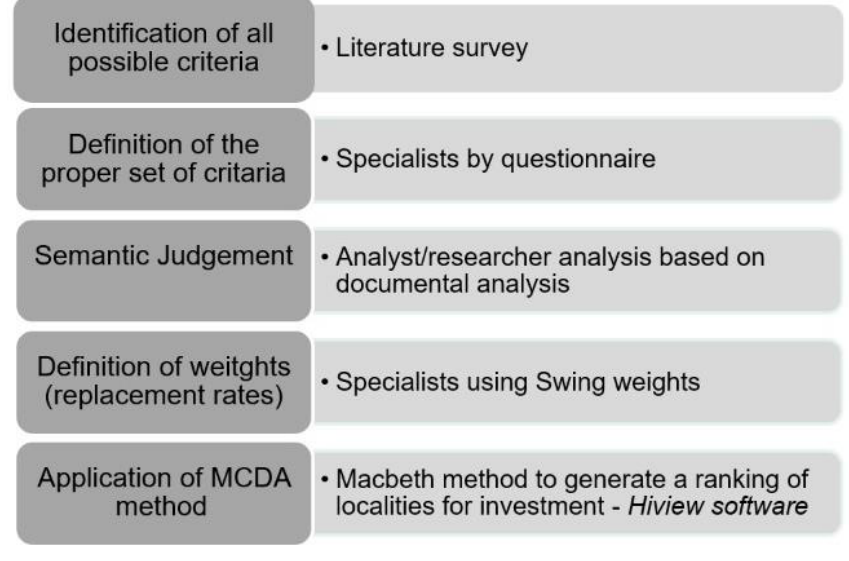
Figure 1. Methodological steps.